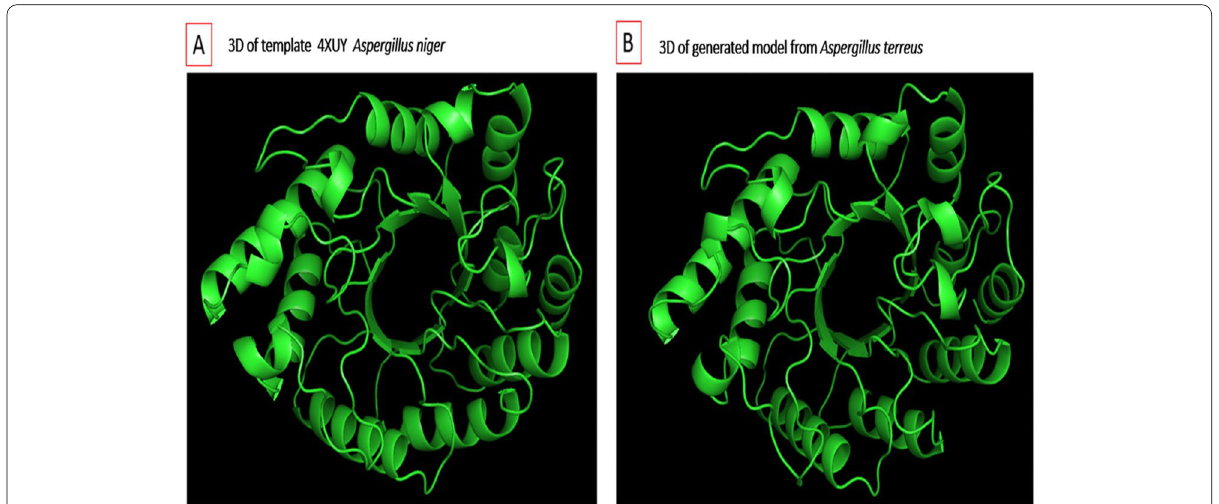
Fig. 22 a Super imposition of modeled xylanase gene from A. terreus (predicted model) and b template Aspergillus niger (PDB 4XUY _A) through cartoon representation